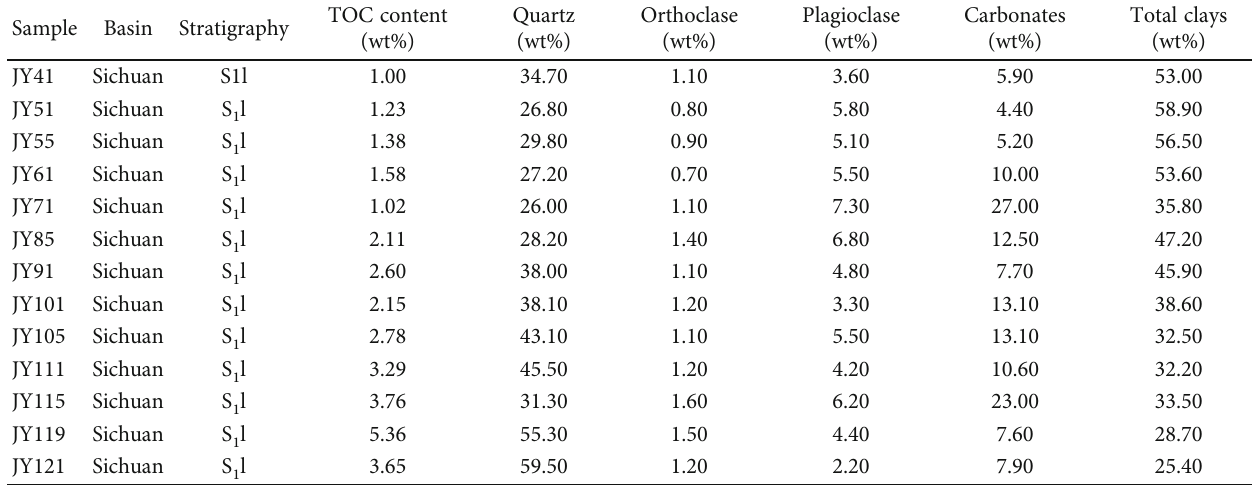
Table 1: TOC and mineral compositions of the investigated marine shale samples.